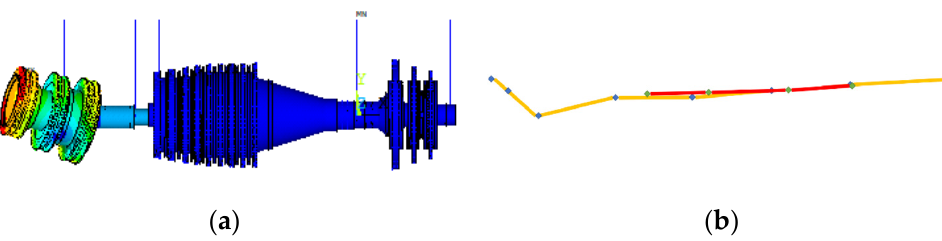
Figure 8. The second-order modal shape comparisons between experiments and FEM analyses: ( a ) The second-order modal shape of FEM analyses; ( b ) The second-order modal shape of LMS.